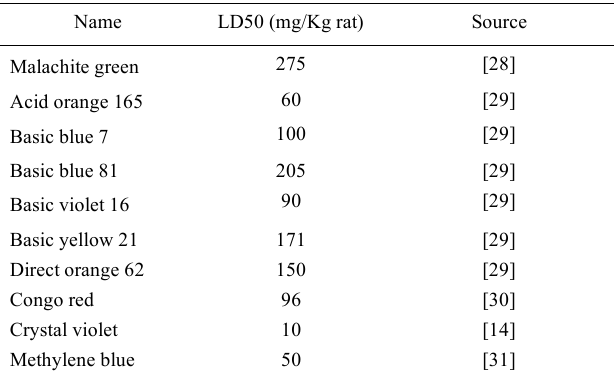
Table 1. Toxicity of some